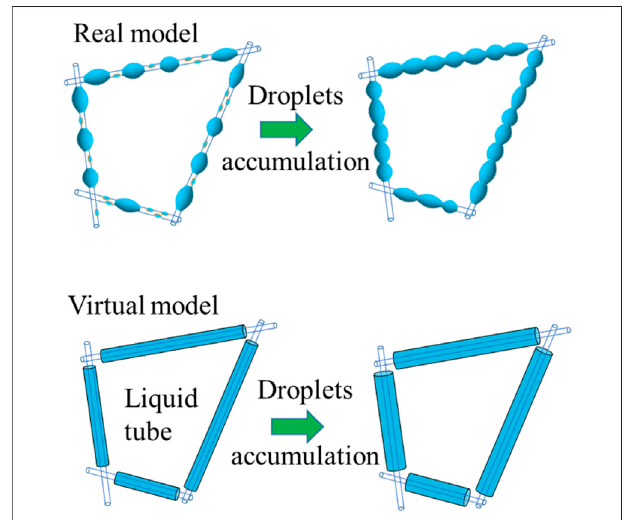
FIGURE 1 | Schematic diagram of “ liquid tube.